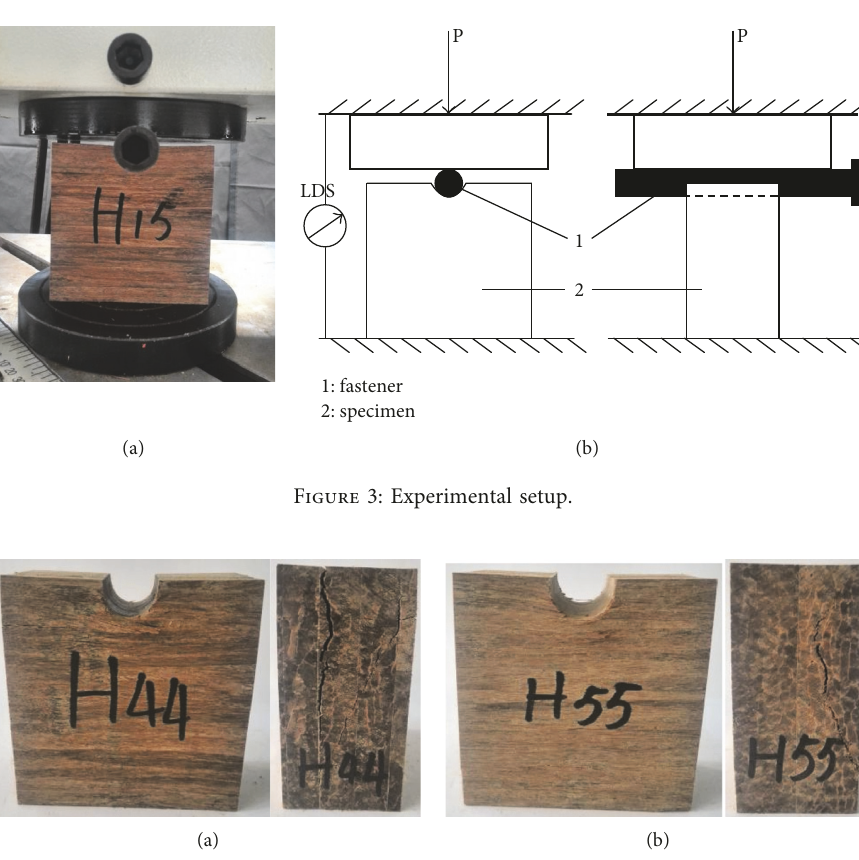
Figure 4: Typical failure mode of the